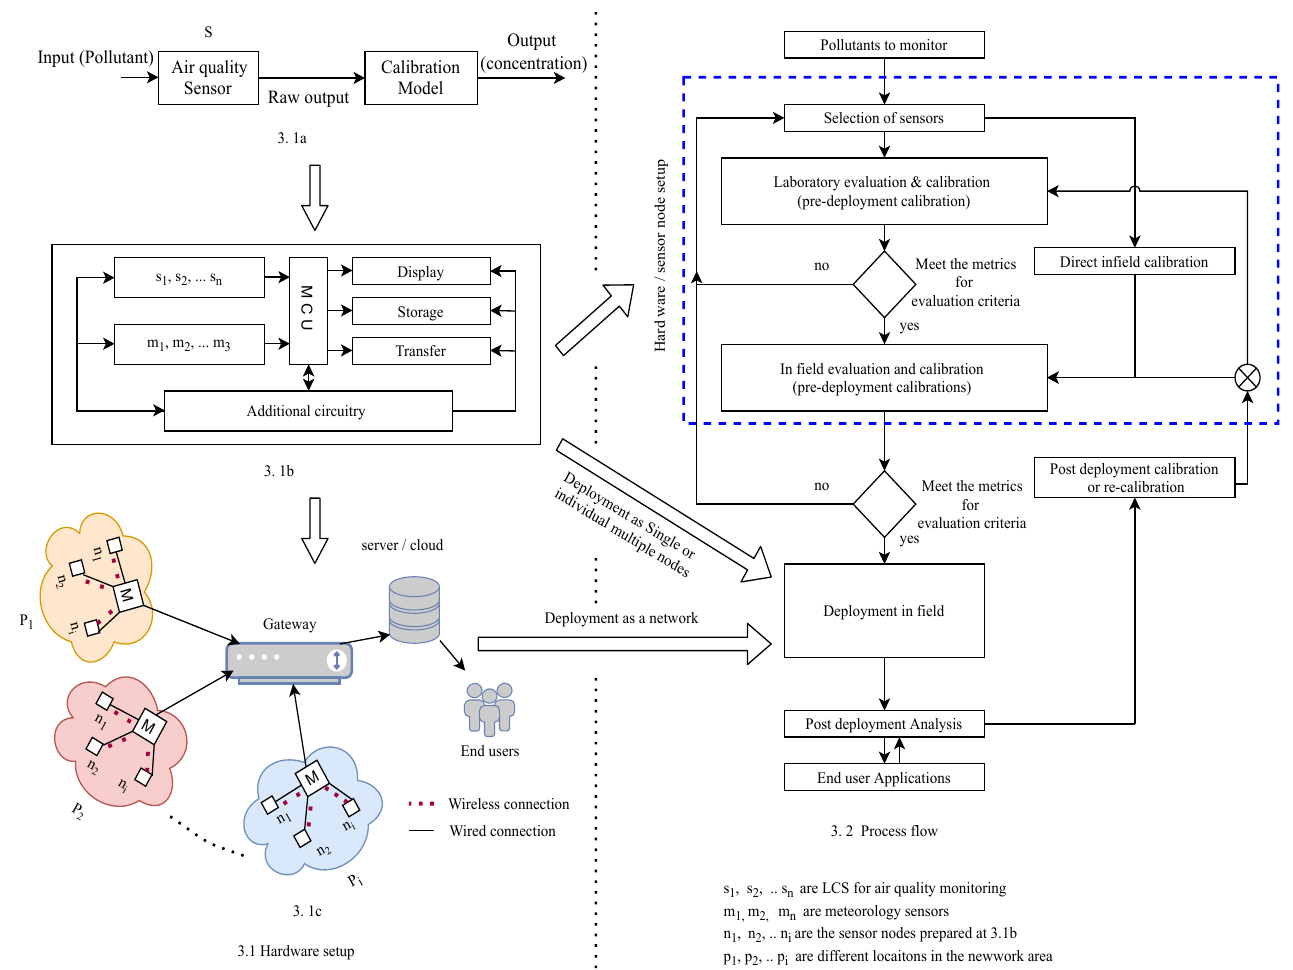
Figure 3. LCS based air pollution measurement framework. 3.1 Hardware setup; 3.1a block box representation of LCS; 3.1b Sensor node/box setup; 3.1c typical sensors network; 3.2 process